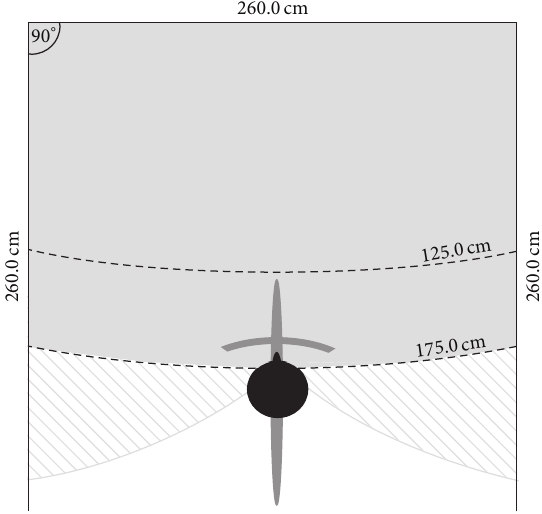
Figure 2: Overhead view of the Immersion Square system , including three screens (bold black lines, each 260.0 cm wide) with a partic- ipant seated on a cycling ergometer (black head and darker grey schematic). Theparticipant’svisualfield(depictedbythelightergrey zoneandiftheheadturnsleft/rightthedashedlightergreyzone)was centred between 125.0 and 175.0 cm from the front